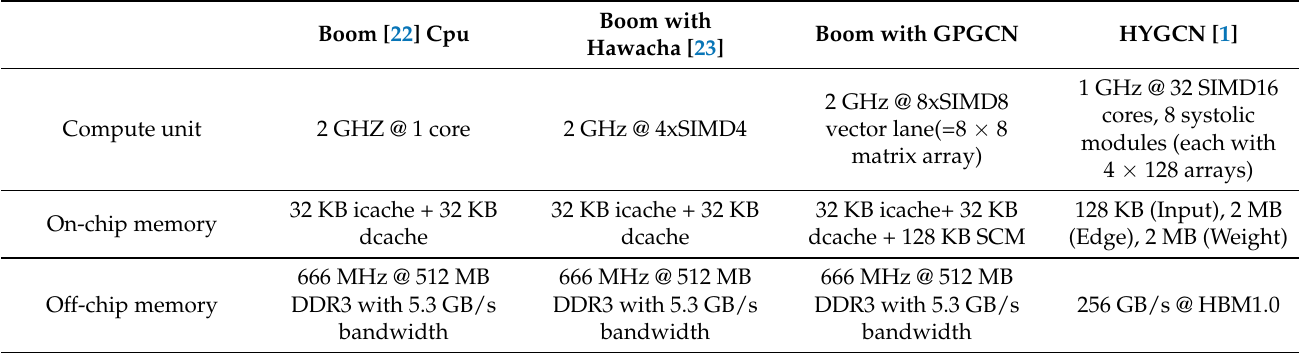
Table 7. The parameter configuration of hardware.